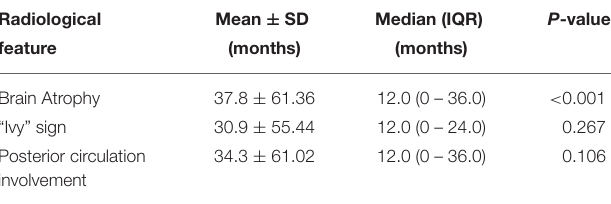
TABLE 7 | Comparison of diagnostic latency with radiological